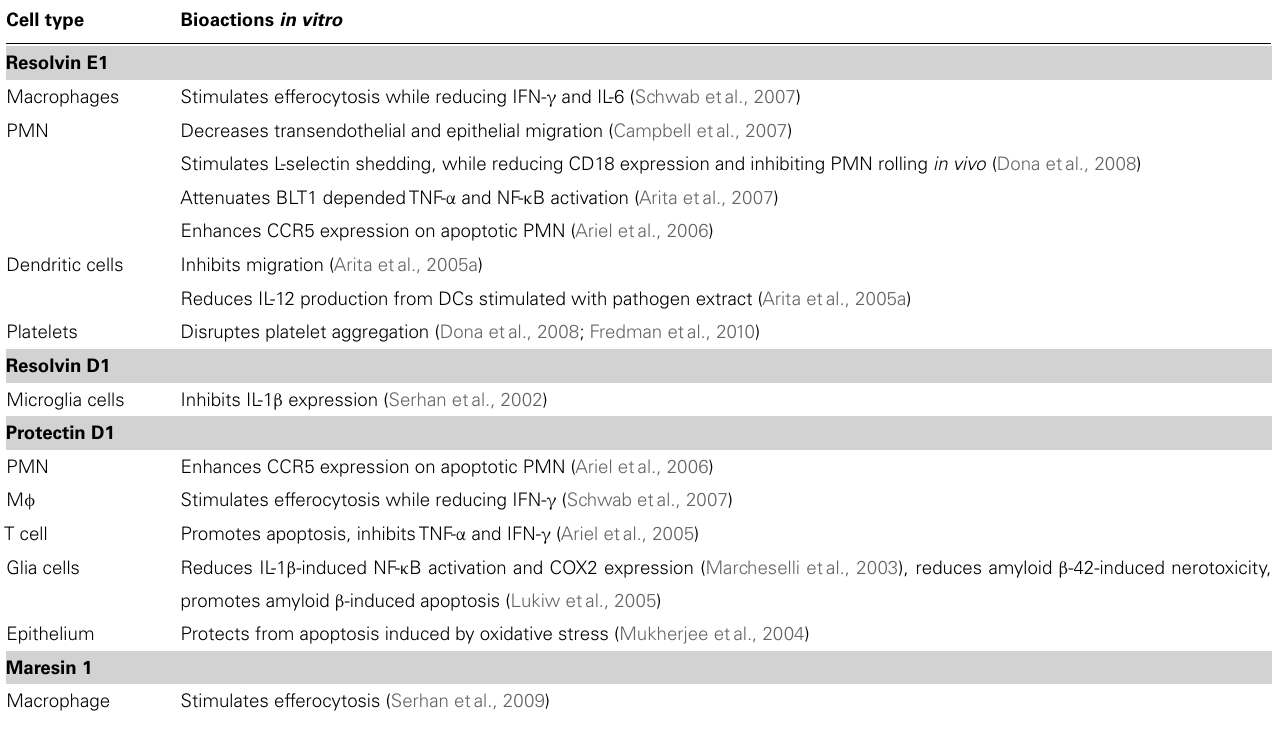
Table 2 | Resolvin, protectin, and maresin induced